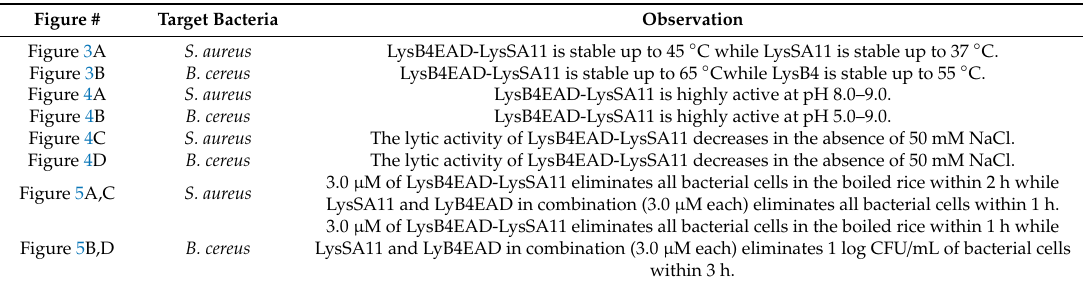
3.0 µ M of LysB4EAD-LysSA11 eliminates all bacterial cells in the boiled rice within 2 h while LysSA11 and LyB4EAD in combination (3.0 µ M each) eliminates all bacterial cells within 1 h. 3.0 µ M of LysB4EAD-LysSA11 eliminates all bacterial cells in the boiled rice within 1 h while Figure 5B,D B. cereus LysSA11 and LyB4EAD in combination (3.0 µ M each) eliminates 1 log CFU / mL of bacterial cells within 3